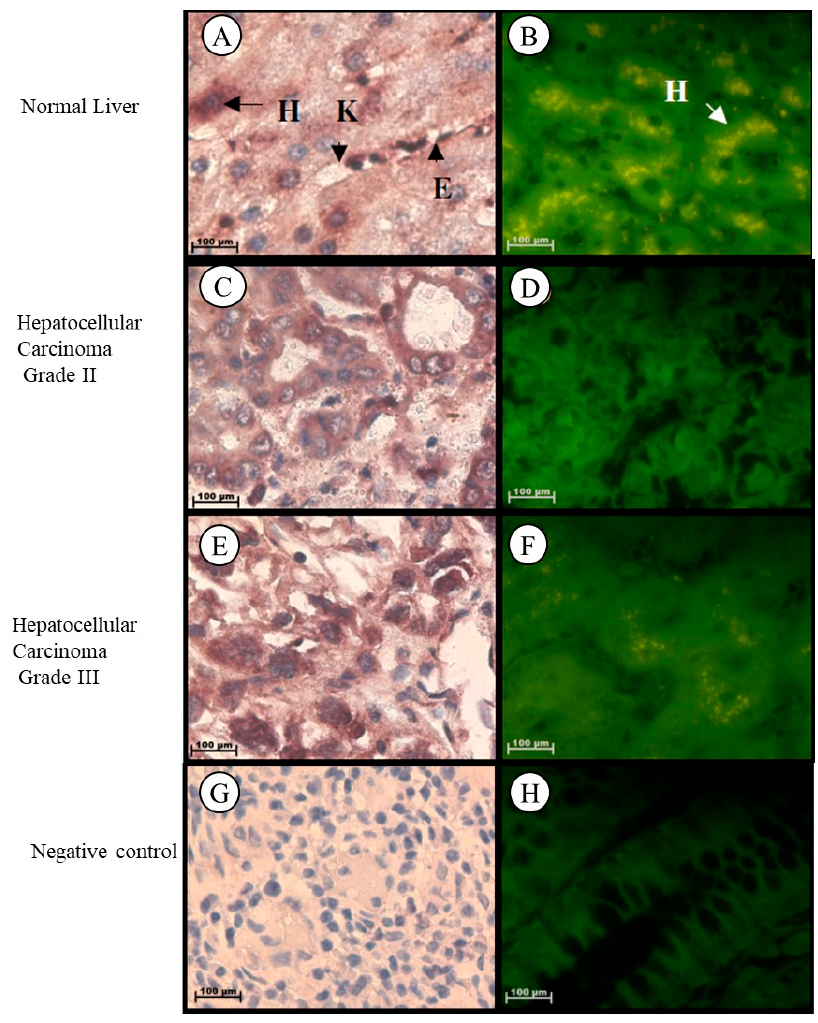
Figure 4. Subcellular Localization of Tspo mRNA in healthy and diseased Liver Tissues: Localization in Normal Liver Tissue ( A , B ) where Tspo mRNA is expressed in the cytoplasm of hepatocytes (H) and in the nuclei and cytoplasm of Kupffer cells (K) and endothelial cells (E) of the sinusoids. A comparison of the fluorescent intensity between cancer ( D , F ) and healthy tissue ( B ) shows a decrease in the expression level of Tspo in cancer. Grade II hepatocellular carcinoma ( C , D ) express PBR mRNA in the cytoplasm of tumour cells having either a trabecular or pseudoglandular pattern while Grade III hepatocellular carcinoma ( E , F ) express PBR mRNA in the nuclei and cytoplasm of tumour cells that resemble anaplastic giant cells to spindle-shaped cells. ( G , H ) Negative control for the subcellular localization of Tspo mRNA. Sense probes were used to probe tissue preparations and this was analysed colorimetrically and fluorescently. Tissues were magnified at 1000×.